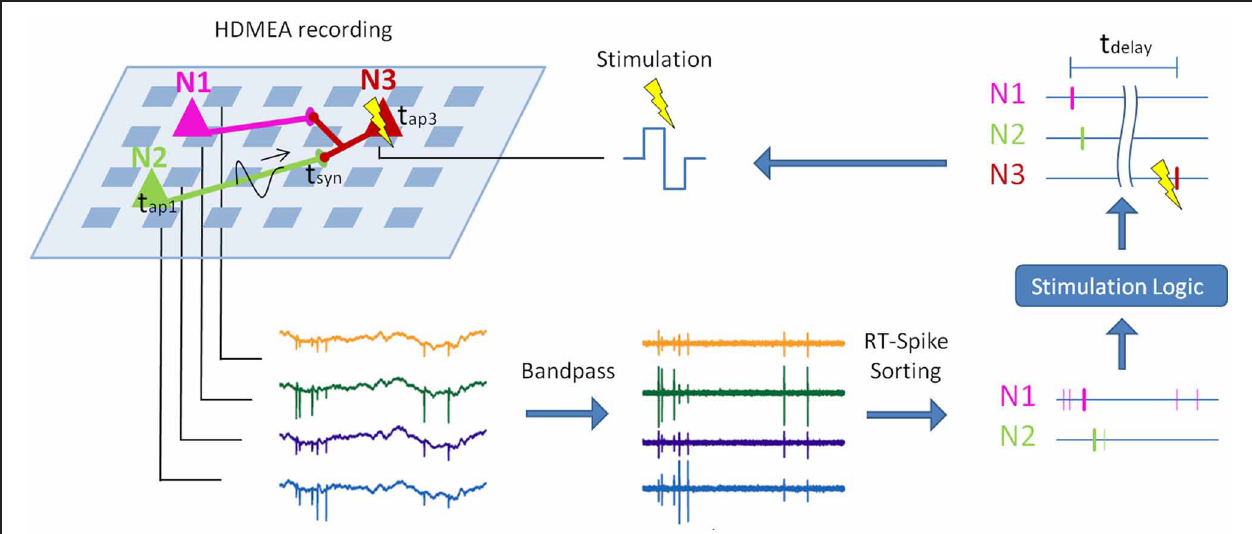
on the sorted spike trains and the stimulation logic, the postsynaptic neuron (N3) is stimulated (Müller et al., in review). If the stimulation latency ( t delay ) is short enough, the stimulation can be timed with respect to the arrival of the action potentials of N1 and N2 at their synapses to N3 ( t syn ). This can be used to change the synapse characteristics via spike-timing-dependent plasticity (Feldman, 2012). Parts of this graph were adopted from Einevoll et al.